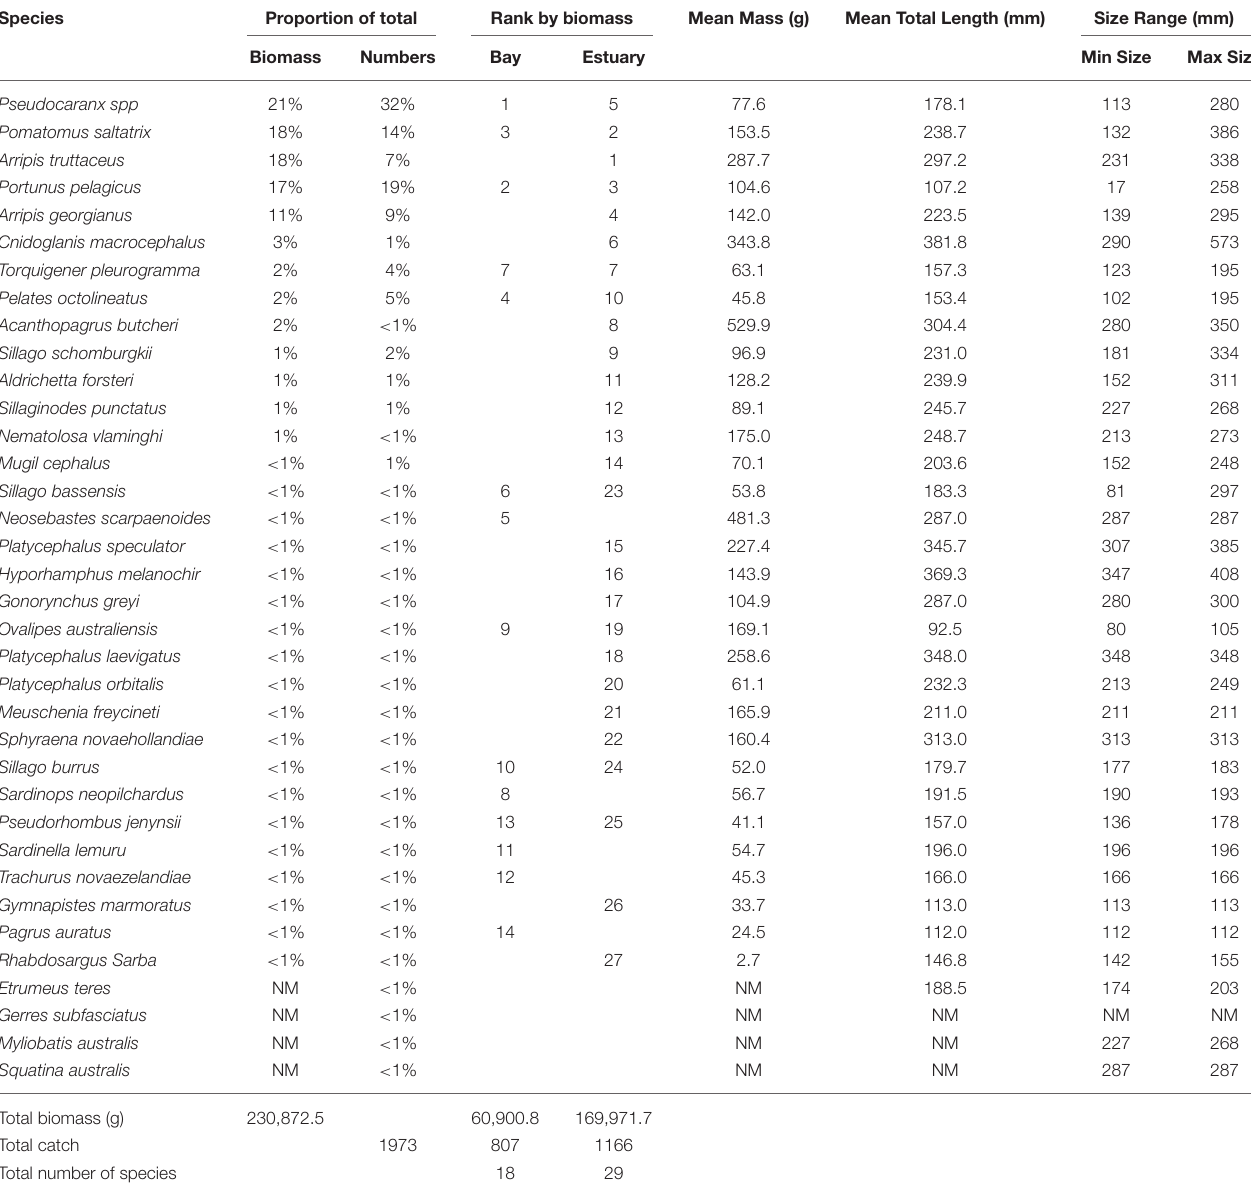
TABLE 4 | Proportion contribution of each species to the total catch in gillnets by biomass (g) and numbers, and the rank by biomass in the Bay, and Estuary.